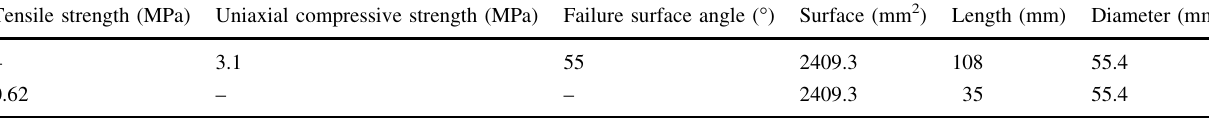
Table 1 Compressive and tensile strength tests